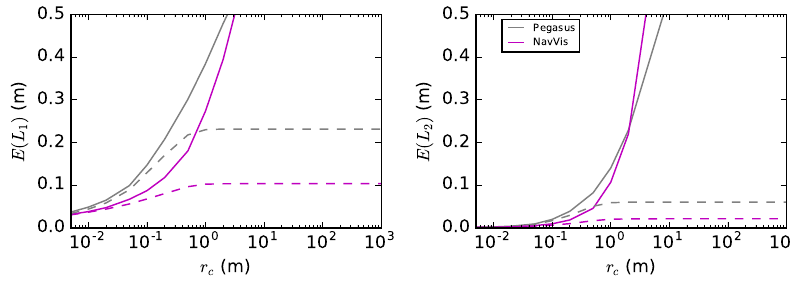
Figure 14. Hallway test site. The error metric E , using L1 ( left ) and L2 ( right ) norms, as a function of the nearest point cut-off distance r c . The plot color legend is shown also in Table 1.